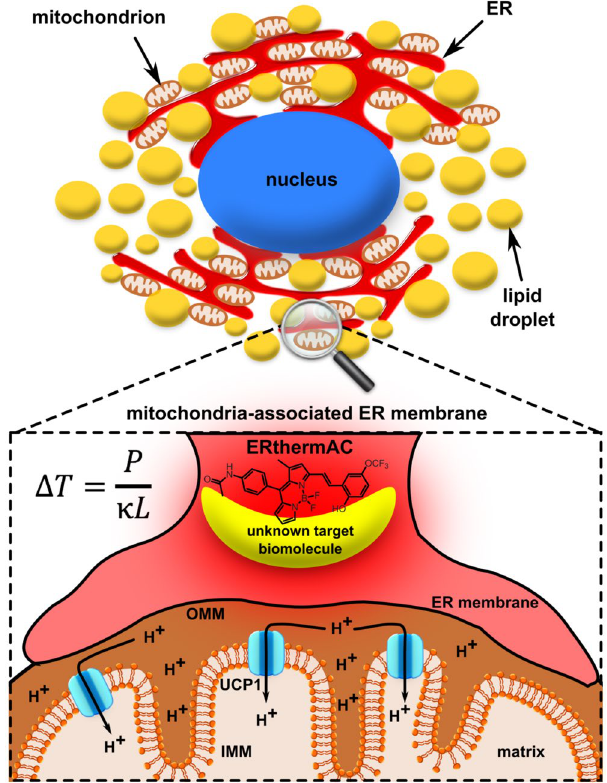
Figure 7. ERthermAC forms a contiguous thermometer in the immediate mitochondrial vicinity by targeting the endoplasmic reticulum. Temperature difference ( Δ T [K]) is proportional to the power of the heat source ( P [W]), and inversely proportional to the distance ( L [m]) from the centre of the heat source and the thermal conductivity surrounding the heat source ( κ [W m − 1 K − 1 ]). Mitochondria-associated ER membrane in adipocytes provides sufficiently close proximity of these two organelles, thus placing ERthermAC into the extensive endoplasmic network and creating an extended contiguous thermometer in the immediate mitochondrial vicinity through targeting of a yet unknown biomolecule. This process is unaffected by radical environmental changes in mitochondria. ER: endoplasmic reticulum; IMM: inner mitochondrial membrane; OMM: outer mitochondrial membrane; UCP1: uncoupling protein